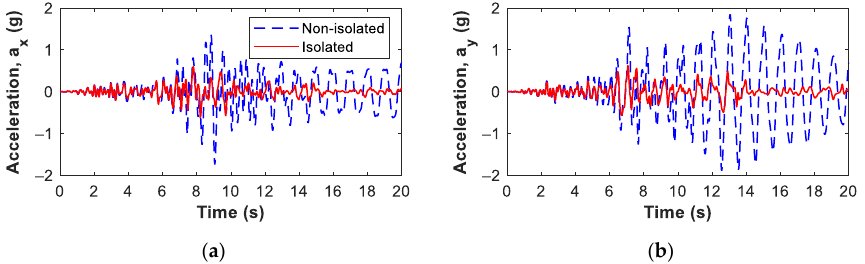
Figure 5. Time history of roof absolute acceleration of the building subjected to Record 1: ( a ) X- response and ( b ) Y-response.